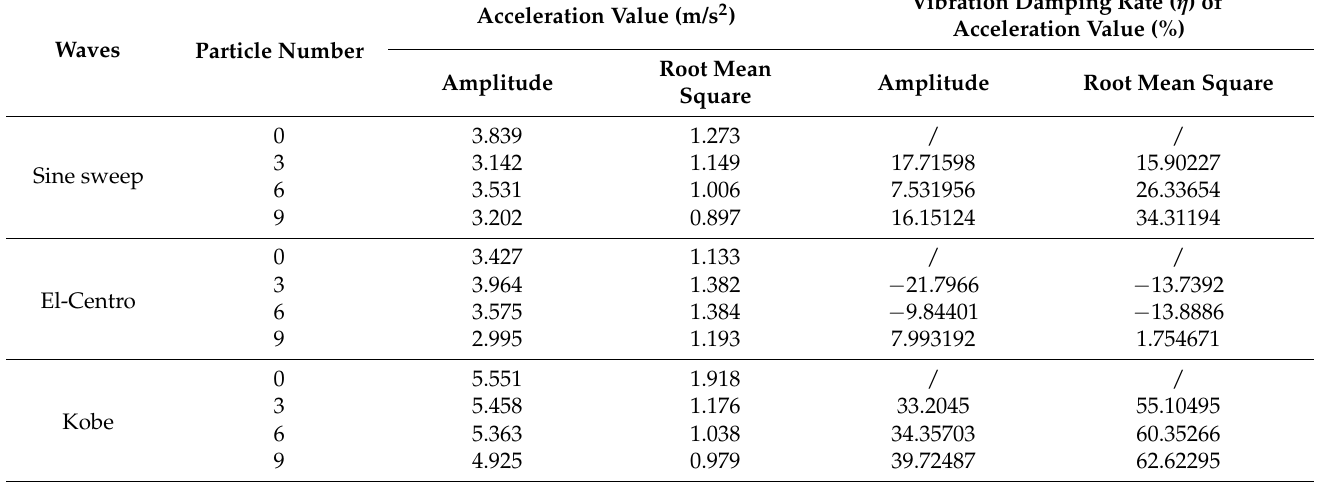
Table 4. Acceleration Response (mass ratio: